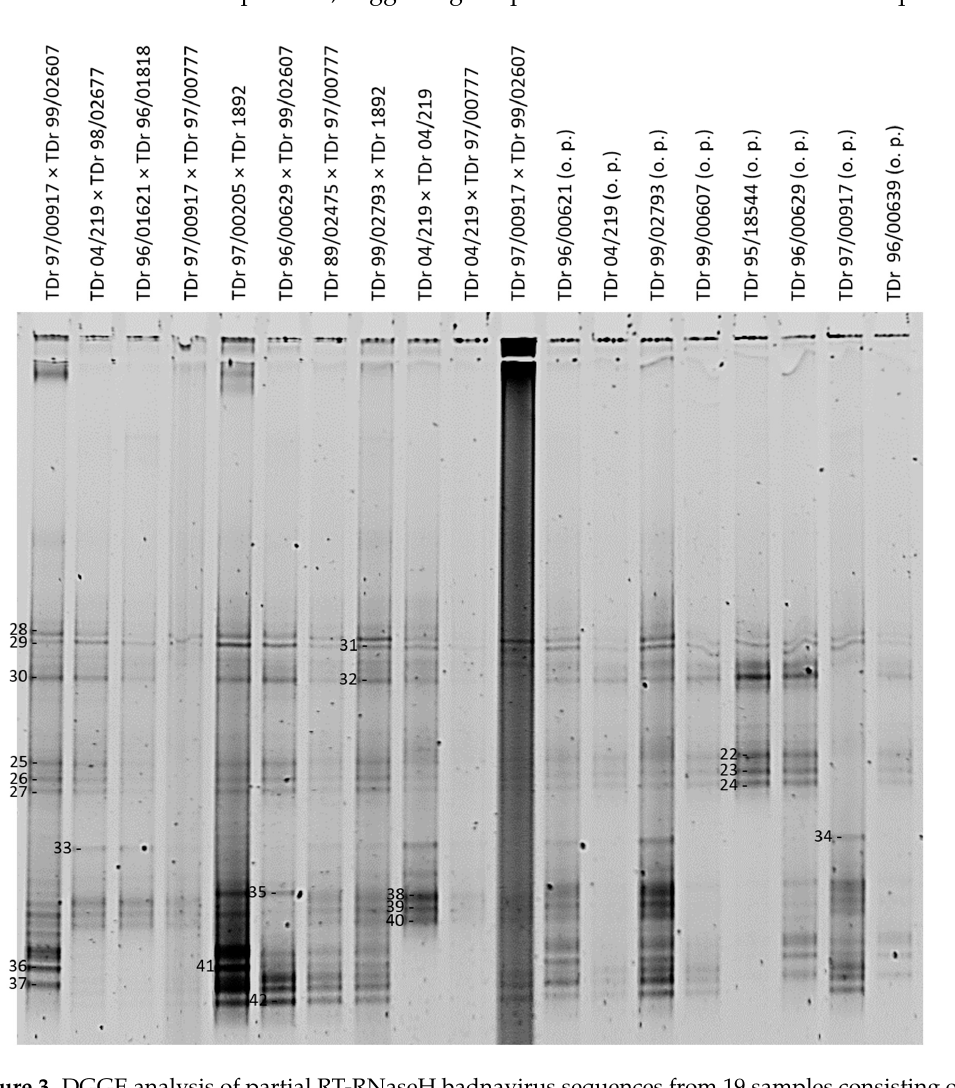
Figure 3. DGGE analysis of partial RT-RNaseH badnavirus sequences from 19 samples consisting of first filial (F 1 ) generations of West African breeding lines (o.p. stands for open pollinated) of D. rotundata comparing patterns of PCR amplifications (20 µ L loaded) using the generic badnavirus primer pair Badna-FP/-RP with a GC clamp fused to the forward primer. The denaturing gradient was 35–50% and DGGE was performed at 80 V at a temperature of 60 °C for 18 h. Band numbers 22–42 were excised and cloned. The corresponding sequences are presented in Table 1. Eleven cross-breeding lines of D. alata were also analysed in this study (Figure S1). Nine out of these 11 cross-breeding lines contain a double-band made out of sequences NGb60Da and NGb61Da, which were found to be 92% identical to GyJT2Dt (AM503389, [34]) and 93% identical to NG1Da (AM944571, [35]), respectively. Sequence NGb60Da appears to be not only common to the majority of D. alata breeding lines tested in this study, but is also common to most of the D. rotundata material tested (e.g., sequence NGb6aDr corresponding to band 6 in Figure 2). Additionally, eight of the 11 cross-breeding lines analysed contain a second double-band which was not resolved very well, but contained sequence NGb63Da identified as 99% identical to SB42Da (AM072696), which was isolated